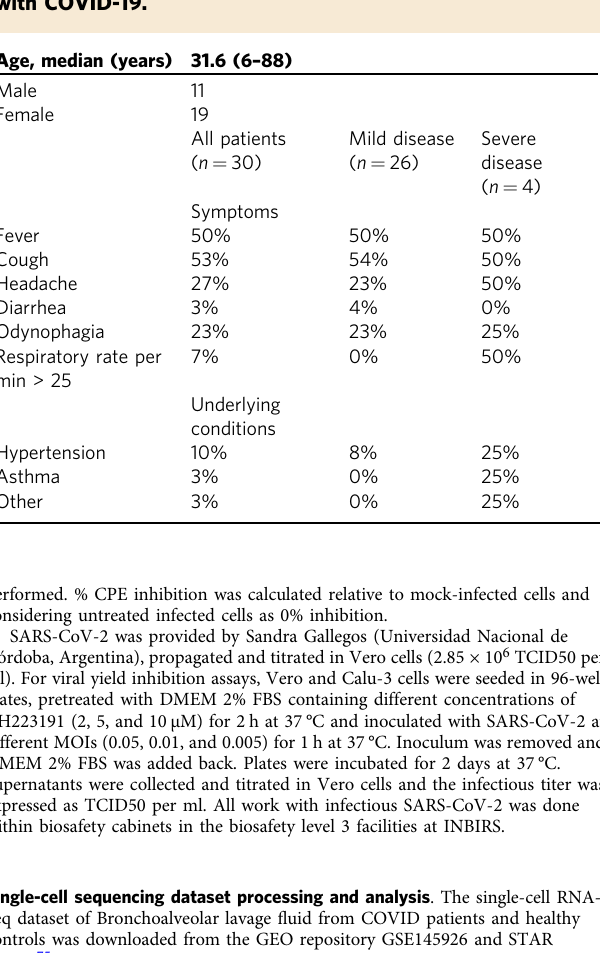
Table 3 Demographic and clinical characteristics of